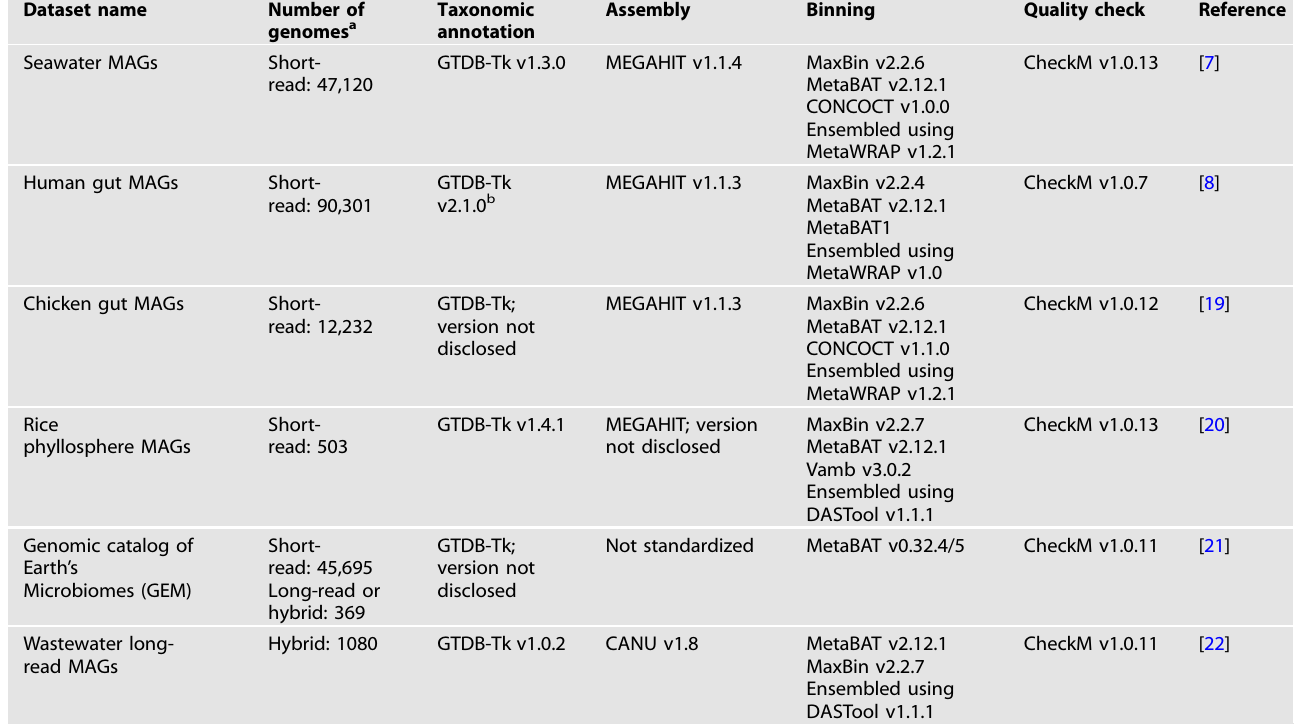
Table 1. Description of six MAG datasets used in this